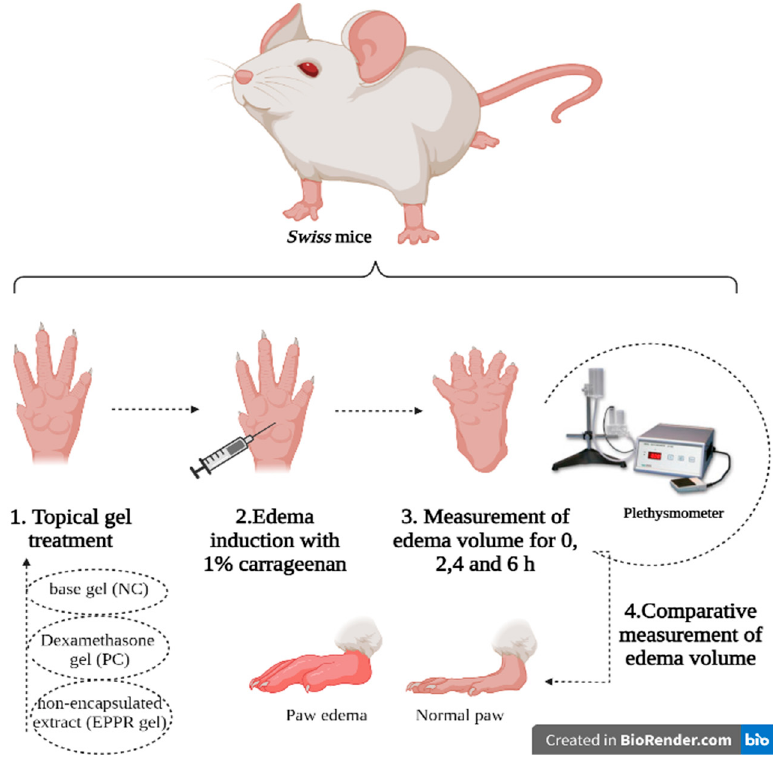
Figure 10. Paw edema model.